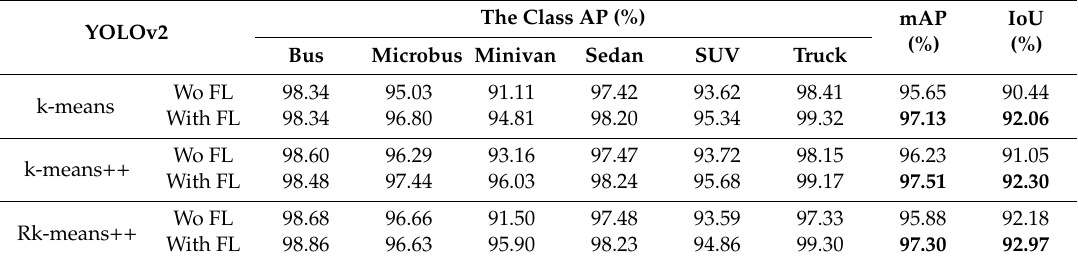
Table 3. Experimental result on comparing YOLOv2 with Focal Loss